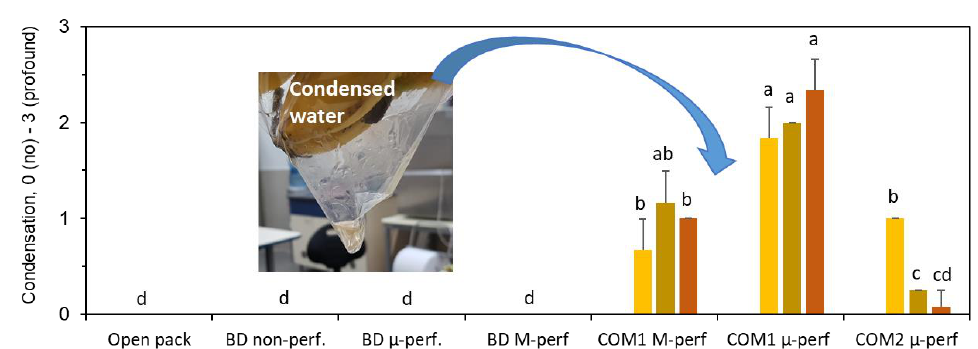
Figure 5. Accumulation of condensed water (visual scores) in banana packages after 3 days of simulated distribution at 15 °C and 1, 3 or 5 days of shelf life/home storage at 24 °C. Package designations are the same as in Figure 2. Error bars represent standard errors of three replications. Different letters above the bars indicate significant differences at p ≤ 0.05, according to Tukey ’ s HSD test. Insert represents a photograph of condensed water accumulated on the bottom of the commercial microperforated CPP-based package.